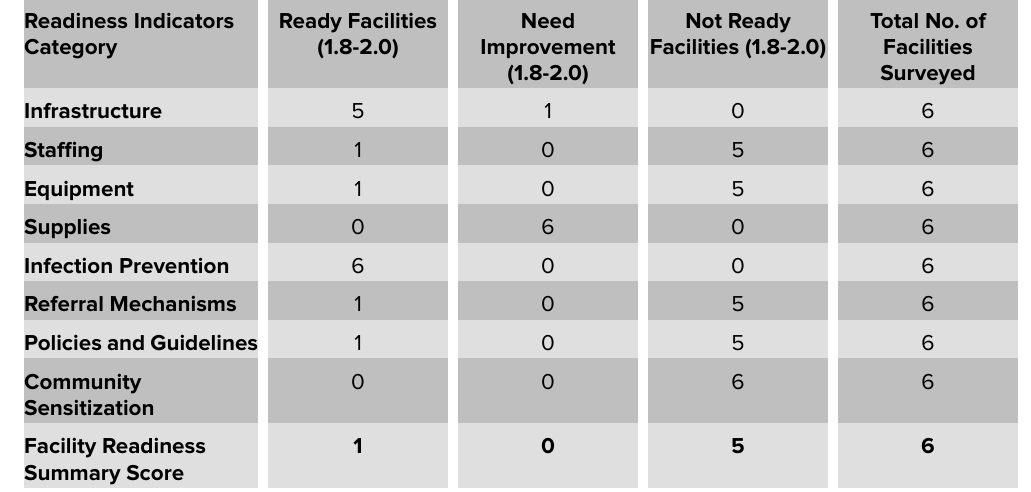
Figure 3: The geographic distribution of cervical cancer services centers in Khartoum state’ seven localities and the availability of service. TABLE 1: Distribution of cervical cancer centers according to facility readiness category scores: Screening